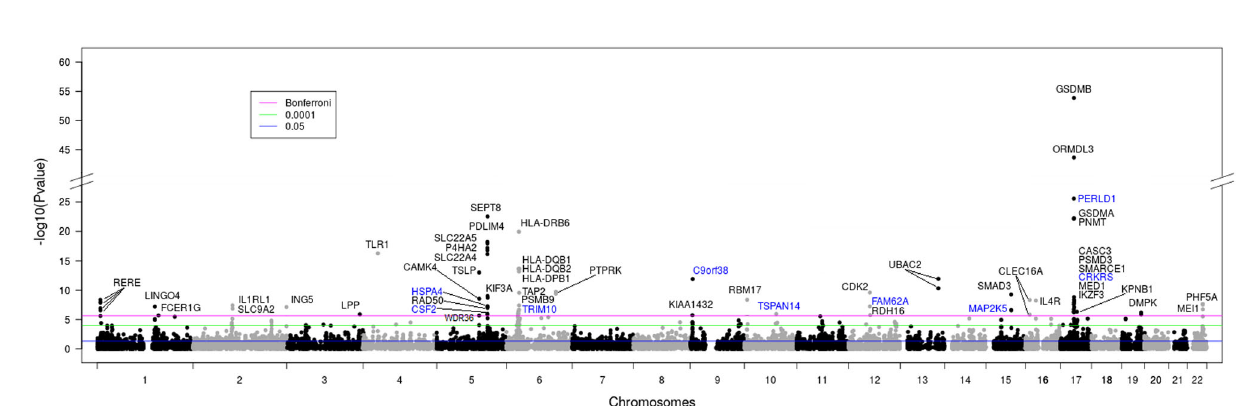
Fig. 3 Manhattan plot of the TWAS on asthma integrating the UK Biobank GWAS and the lung eQTL dataset. Each dot represents the association between predicted gene expression and asthma for a speci fi c probe/transcript. P values for gene expression-asthma associations are on the y axis in − log10 scale. The blue, green, and magenta horizontal lines represent P − 6 (Bonferroni), respectively. Annotations for TWAS of 0.05, 0.0001, and 2.51E genome-wide signi fi cant probes/transcripts that passed Bonferroni correction are indicated. Genes in blue have not been reported in previous asthma